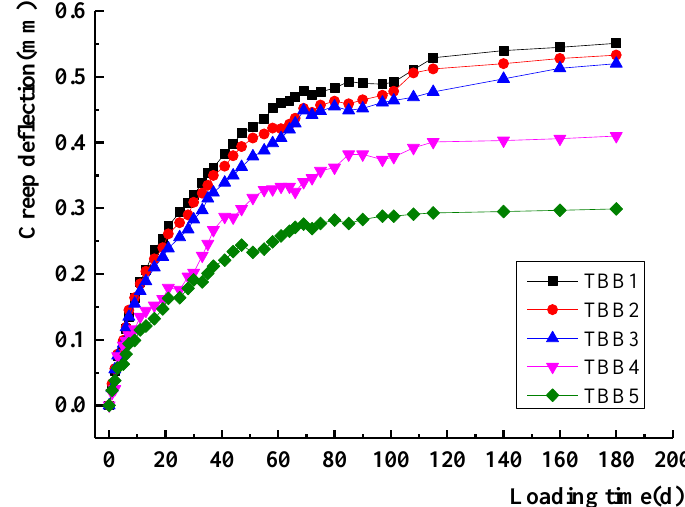
Figure 4. Curves of creep deflection–loading time of test beams with different V/Ss.